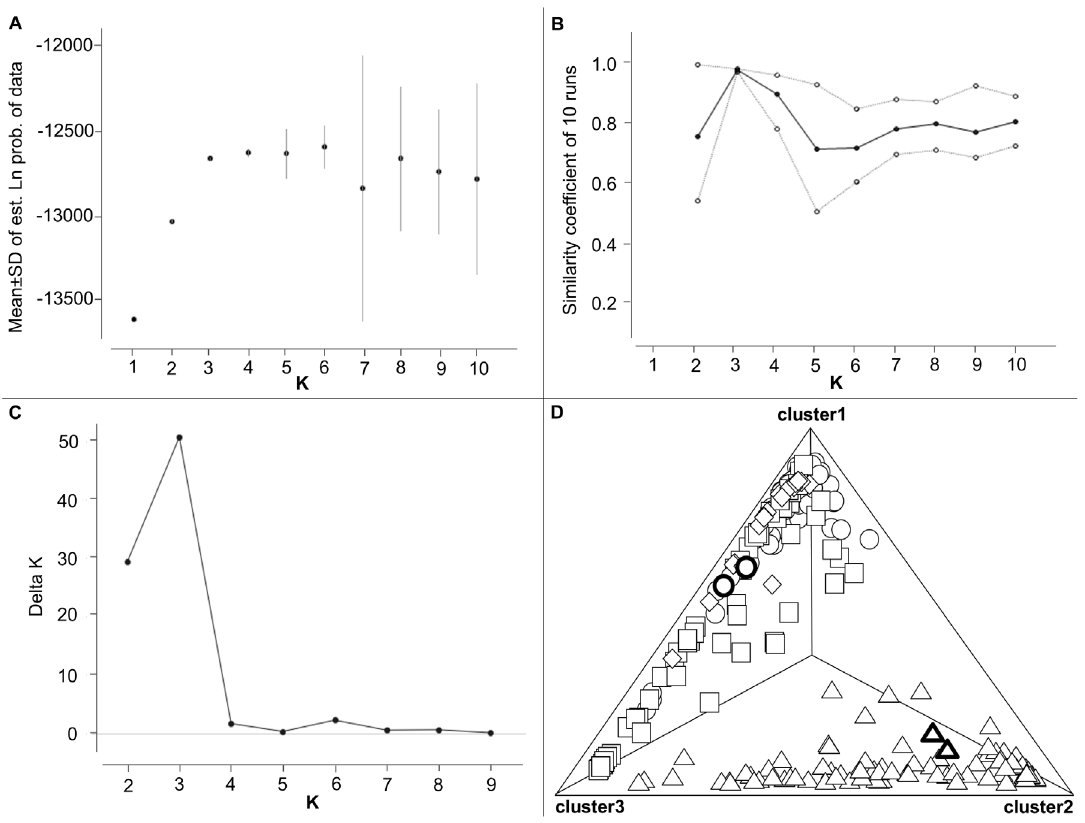
Figure 4. Determination of the number of clusters best fitting the AFLP data: STRUCTURE-based mean ± SD likelihood values of ten runs for each K from K=1 to 10 (A), similarity coefficient (min., mean and max values) of ten runs for each K from K=1 to 10 (mean ± SD) (B), Delta K statistic (C), and Triangle plot with allocation of individuals to clusters mapped according to K=3 (D). Where # : specimens from the North Danubian region (the two emphasized individuals are identified as Gobio gobio in the CR analysis), % : Middle Danubian sites, e : South Danubian sites, n : specimens from the Tisza region (the two emphasized individuals are identified as Gobio carpathicus in the CR analysis).